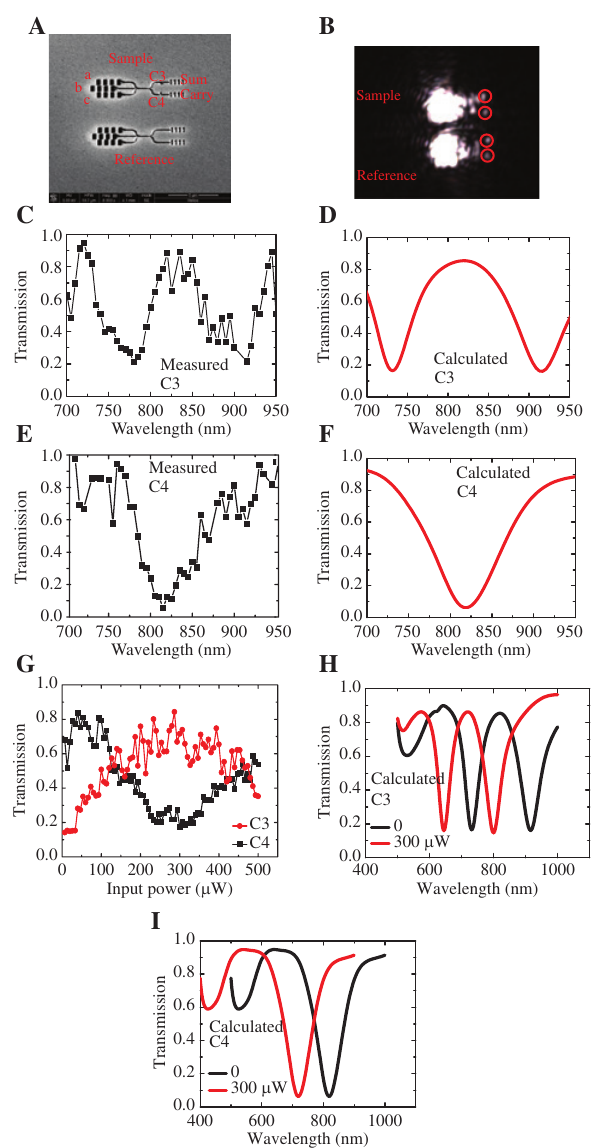
Figure 3: Characterization of the full-adder sample. (A) The SEM image of the full-adder and reference waveguides, without the nano-Au:(IR140:MEH-PPV) cover layer. (B) Measured CCD image of the full-adder sample and reference waveguides under excita- tion of a 730-nm CW laser beam. Measured (C) and calculated (D) linear transmission spectra of the plasmonic waveguide side coupled the plasmonic composite nanocavity C3 having the nano-Au:(IR140:MEH-PPV) cover layer. Measured (E) and calcu- lated (F) linear transmission spectra of the plasmonic waveguide side coupled the plasmonic nanocavity C4 having the nano- Au:(IR140:MEH-PPV) cover layer. (G) Measured transmission changes of a 770-nm, 120-fs incident light propagating through the X-shape-crossed plasmonic waveguides side-coupled plasmonic nanocavities C3 (and C4) covered with the nano-Au:(IR140:MEH- PPV) cover layer as a function of the incident power. Calculated transmission spectra of the X-shape-crossed plasmonic waveguides side-coupled plasmonic nanocavities C3 (H) and C4 (I) having the nano-Au:(IR140:MEH-PPV) cover layer for different incident